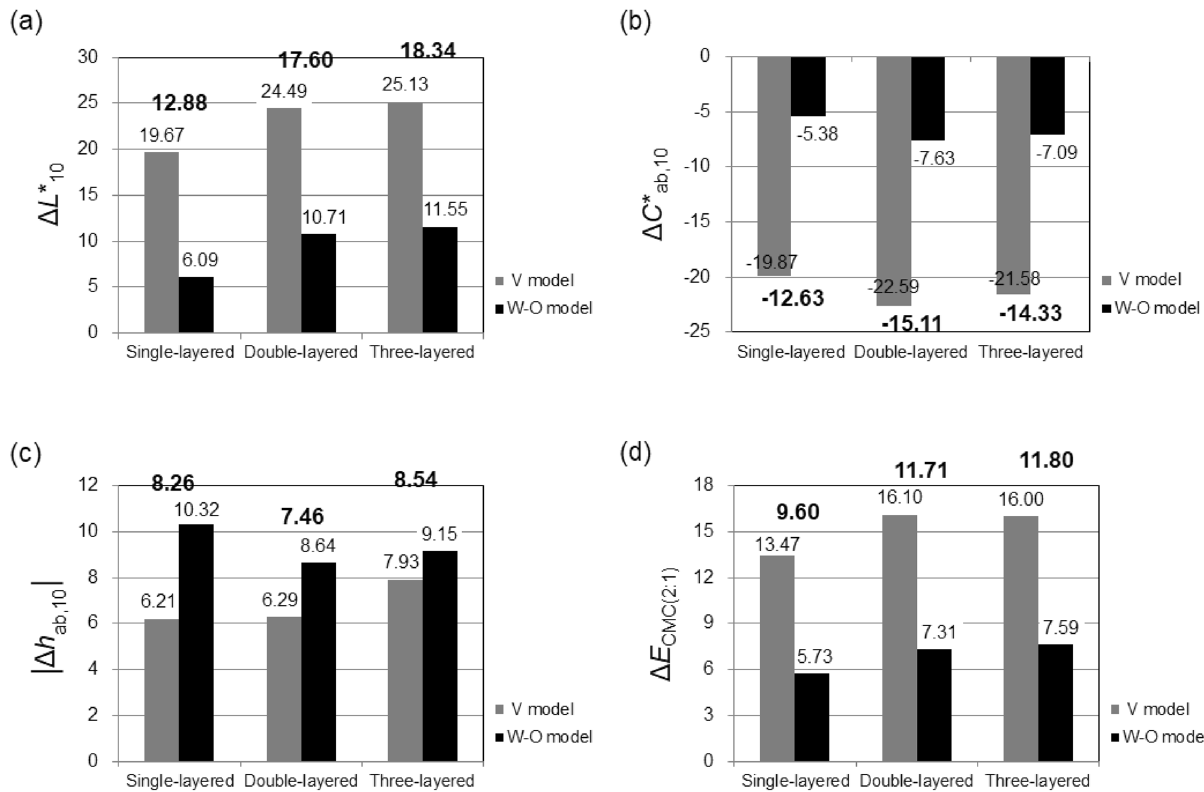
Figure 6. Average color differences, ( a ) Δ L * 10 , ( b ) Δ C * ab,10 , ( c ) │ Δ h ab,10 │ , and ( d ) Δ E CMC(2:1) , between the measured and the predicted colors of single-, double-, and three-layered fabric samples yielded by two- dimensional color prediction models. The color differences were calculated by subtracting the measured color attribute from the predicted color